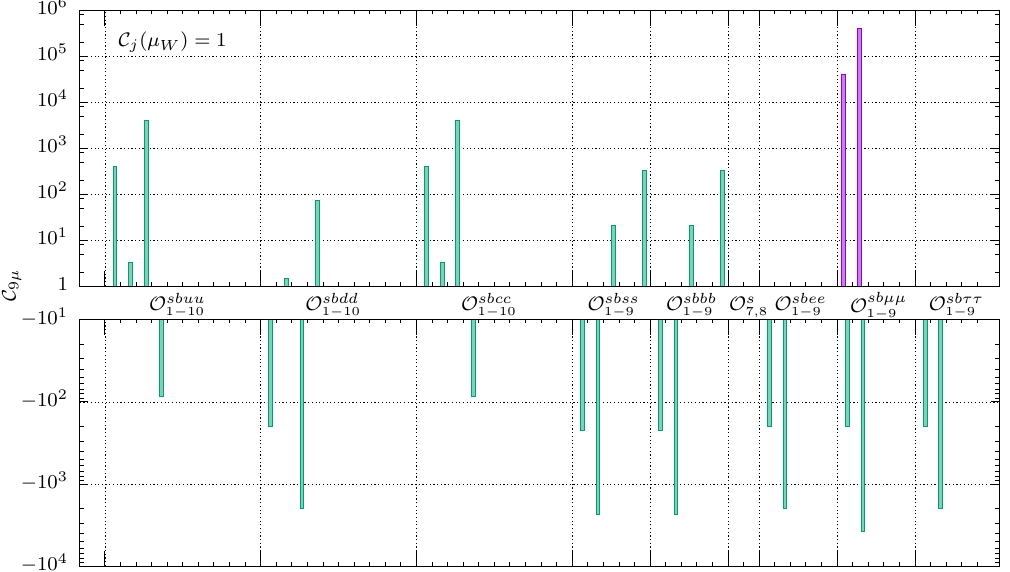
Figure 3. Contributions to C 9 (cid:22) as de(cid:12)ned in (6.2) assuming C j ( (cid:22) W ) = 1 for each operator O j in Class